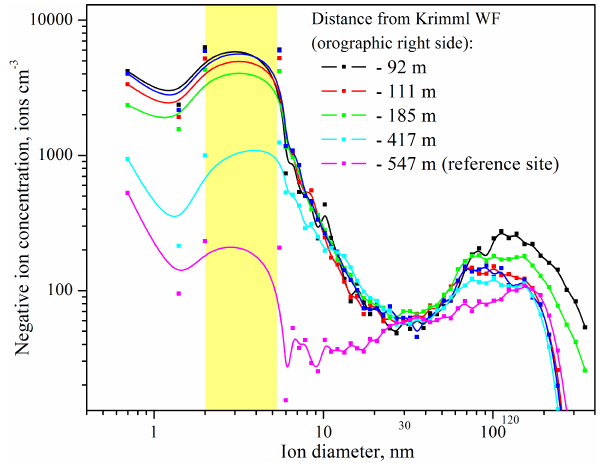
Fig. 9. Ion concentration distribution by size measured at differ- ent distances on 1 July 2010 at Krimml WF, orographic right side. Shaded area indicates interpolated values (cubic B-spline) between CDI-06 (0.36-2.0nm) and SMPS (5.5–350nm) measurements. The 547 m data series (magenta curve) represents the reference site where no WF-generated ions were expected to